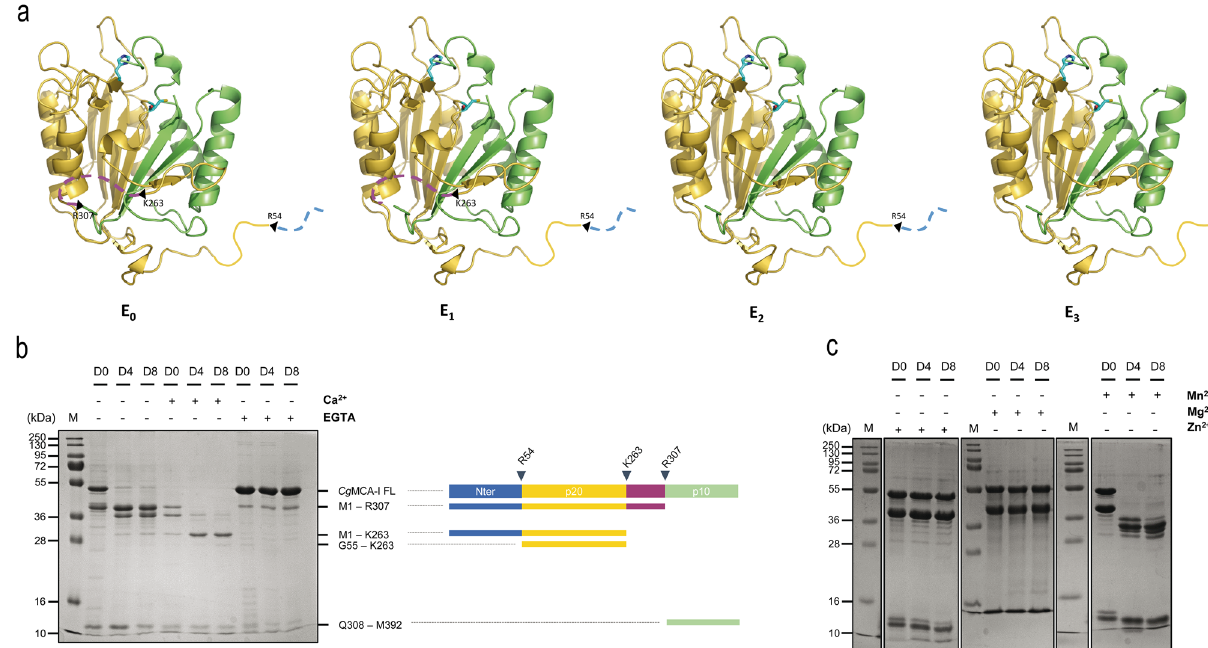
Fig. 1 Maturation of Cg MCA-I in the presence or absence of divalent cations and EGTA. a Structural representation of maturation intermediate forms of Cg MCA-I starting from the non-matured form (E 0 ), after the fi rst and second cleavage (E 1 and E 2 respectively), and the mature form (E 3 ). b SDS-PAGE of Cg MCA-I aliquots at maturation day 0 (D0), 4 (D4) or 8 (D8) in the presence or absence of Ca 2 + (10 mM) or EGTA (1 mM). The band at 48 kDa